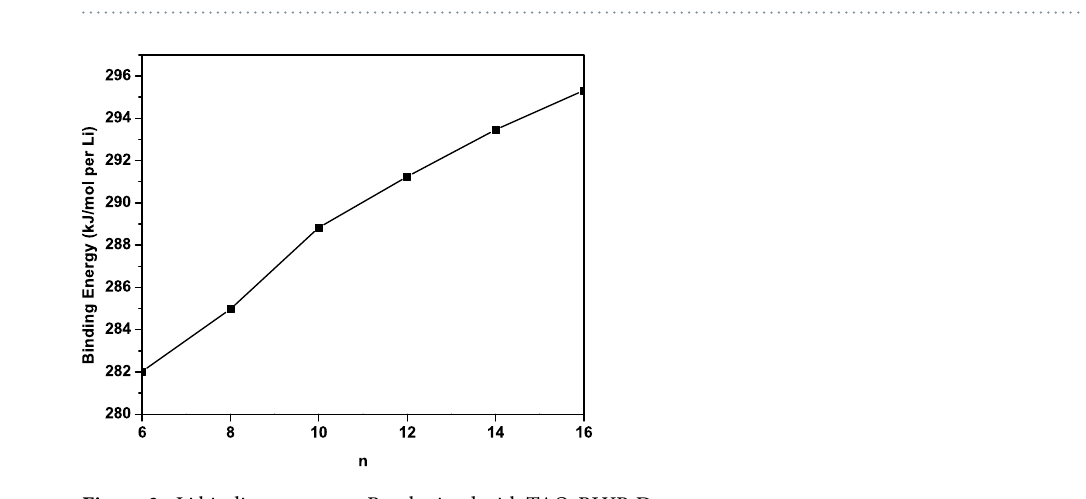
Figure 3. Li binding energy on B n , obtained with